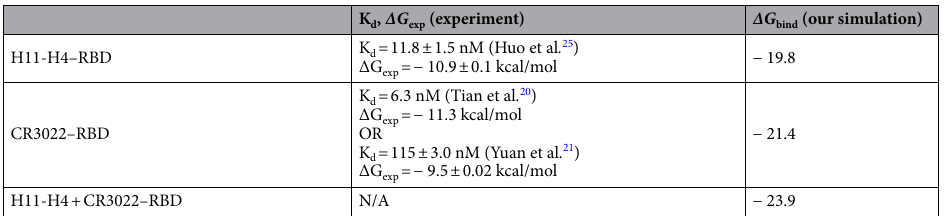
Table 1. Dissociation constant K d (nM) obtained by in vitro experiment. The experimental binding free energy ∆G exp was converted from K d using (cid:31) G exp = RTlnK d . Binding free energy ∆G bind (kcal/mol) was obtained using coarse-grained umbrella sampling and Eq. (4) for the H11-H4–RBD, CR3022–RBD, and H11- H4 + CR3022–RBD complexes. Shown is the WT case